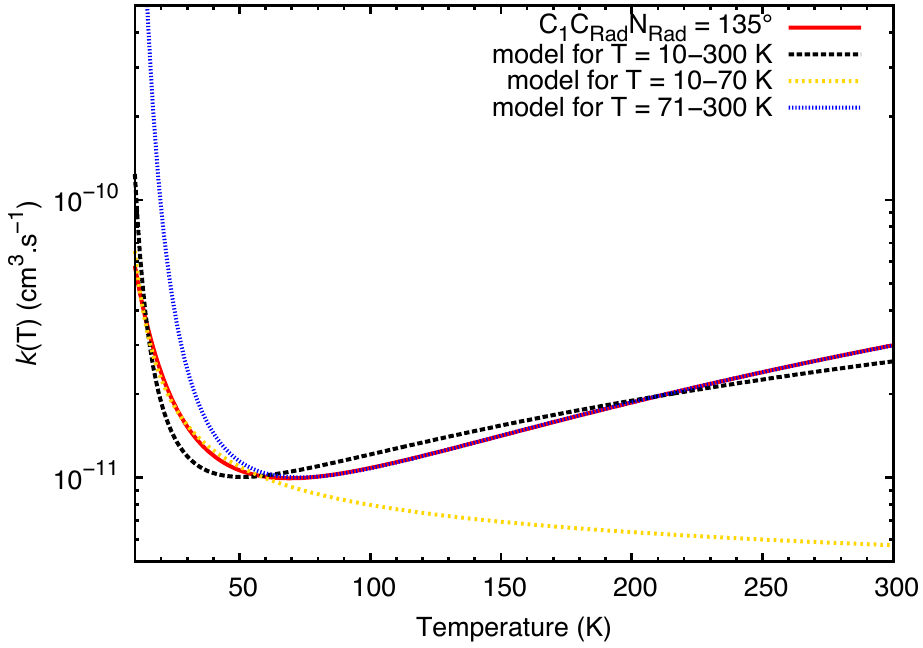
(cid:92) C 1 C Rad N Rad = 135 ◦ . The rate coefficients obtained through Figure 4. Comparison between fittings for capture and RRKM theory are represented in red. In black, the fitting of the curve performed for the temperature range from 10 to 300 K. In yellow, the fitting of the data from 10 to 70 K. In blue, the fitting for a temperature spanning from 71 to 300